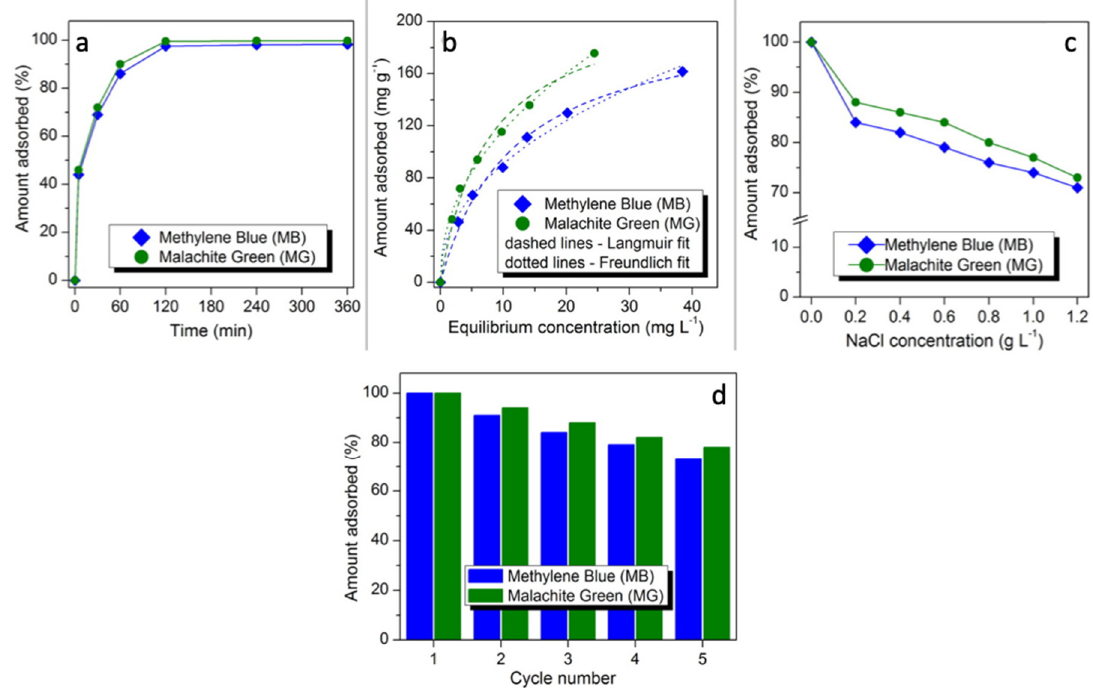
Figure 5. Effect of contact time on adsorption of dyes ( a ), adsorption isotherms with their fitting to Langmuir and Freundlich models ( b ), effect of NaCl addition on adsorption of dyes ( c ), relative adsorption uptakes after sorbent regeneration ( d ). Please note that fitting data are given in the Supplementary material.